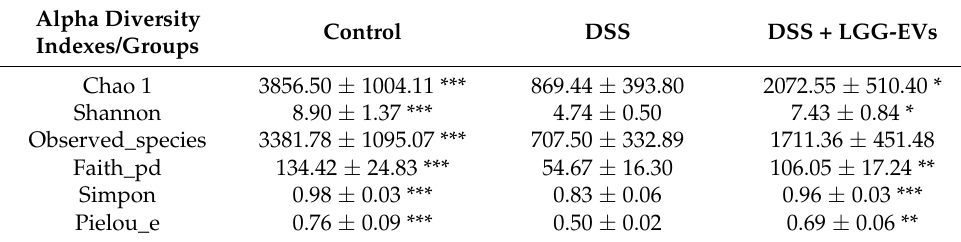
Table 5. Alpha diversity indexes calculated with QIIME2 according to ASV/OTU numbers of each group ( n =